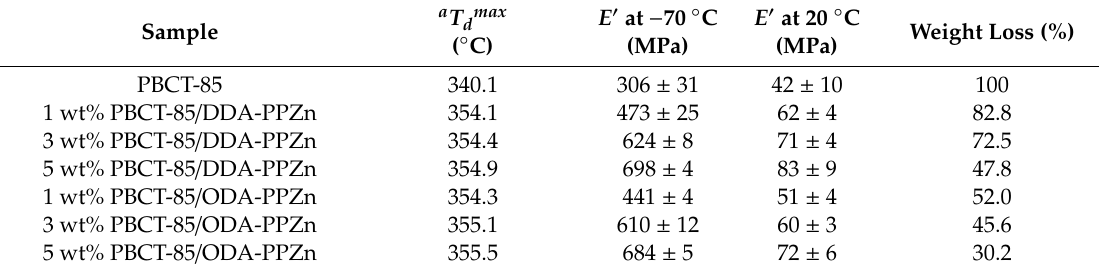
Table 3. The temperature of the maximum degradation rate, storage modulus, and weight loss after 24 h degradation time of the various PBCT / m-PPZn nanocomposites.